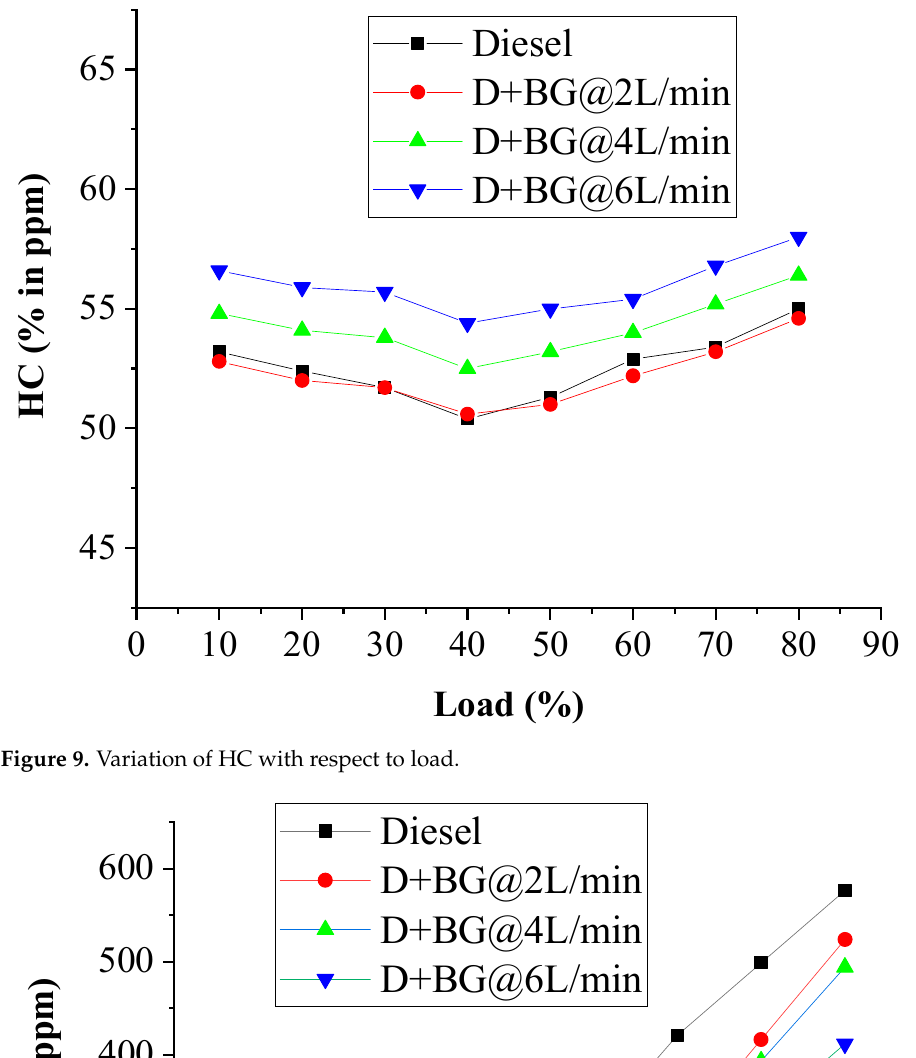
Figure 8. Variation of CO